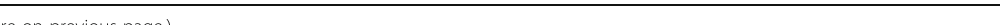
(See figure on previous page.) Fig. 8 Effects of SHH and FGF inhibitors on taste bud numbers and distribution. Taste buds on the body surface, including the craniofacial region (in green) are visualized by anti-calretinin antibody. Blue staining shows nucleus labeled by DAPI. a – f , lateral ( a – c ) and dorsal ( d – f ) views of the head. g – i , lateral views of the trunk. j – l , lateral views of the tail. a , d , g , and j show control embryos at 5 dpf. b , e , h , and k show cyclopamine- treated embryos. c , f , i , and l show SU5402-treated embryos. m – z , quantification of the number of taste buds on barbels ( m – o ), craniofacial regions ( p , r ) and adipose fin (s) in cyclopamine-treated embryos. Inhibition of SHH signal significantly reduced numbers of body surface taste buds, including the craniofacial region, except for the mandibular region ( m – o , q – s ). In contrast, the numbers of taste buds were significantly increased in the mandibular region ( p ). t – z , quantification of the number of taste buds on barbels ( t – v ), craniofacial and trunk regions, including the mandibular apparatus ( w ), head ( x ), upper and lower lips ( y ), and adipose fin ( z ) in SU5402-treated embryos. Inhibition of FGF signal significantly reduced the number of taste buds on the whole of the body surface, including the craniofacial region. Error bars are standard deviation (SD). Data denoted by the same letter do not differ significantly (* P > 0.05; ** P > 0.01) based on Tukey ’ s HSD test or the Steel – Dwass test after analysis of homogeneity of variance by Bartlett ’ s test. adp, adipose fin; he, head region; li, lip; mdb, mandibular barbel; mxb, maxillary barbel; pf, pectoral fin; tail region. Anterior is left in all images. Scale bars are 500 μ